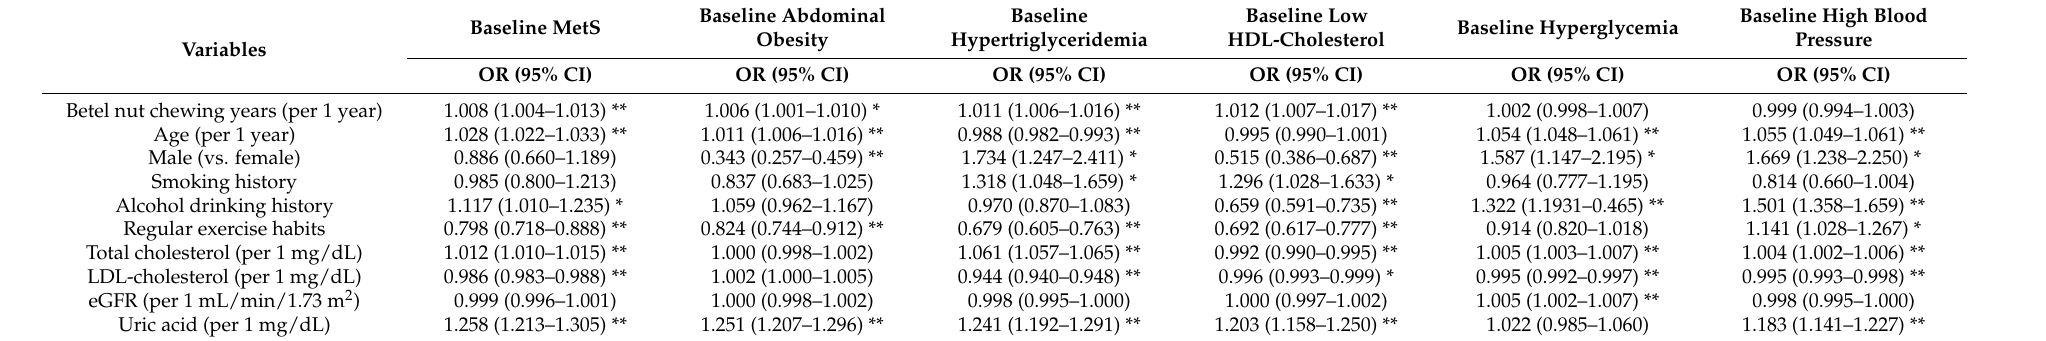
Table 3. Association of betel nut chewing years with baseline MetS and its components in study participants with betel nut chewing history ( n = 7355) using multivariable logistic regression